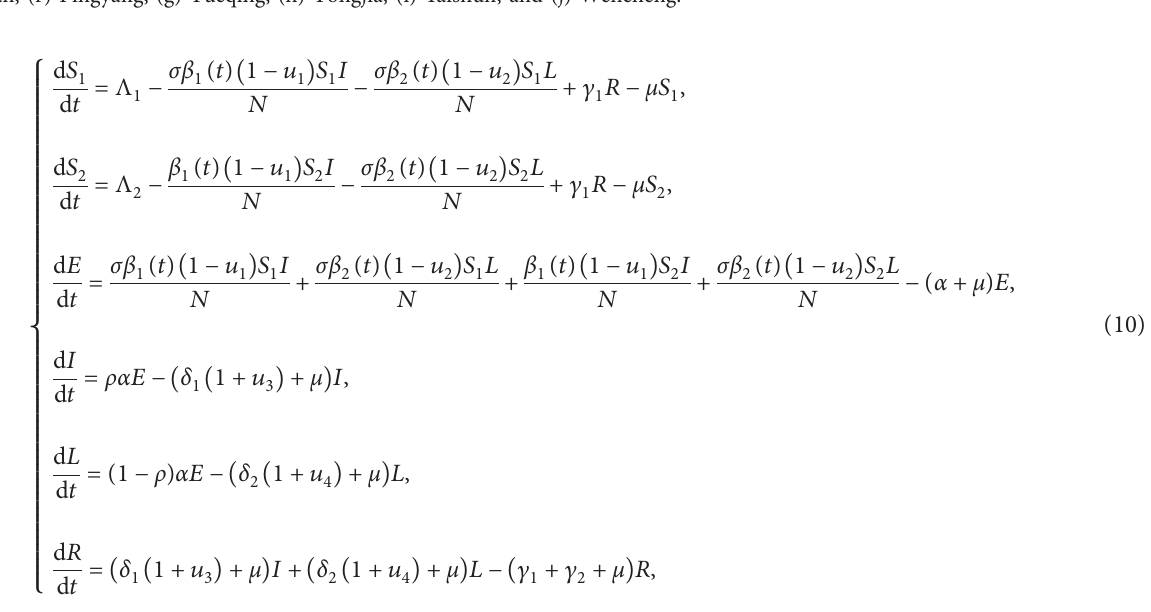
Figure 4: The reported data vs. the numerical solution of the HFMD model (1) in (a) Lucheng, (b) Ouhai, (c) Longwan, (d) Rui’an, (e) Cangnan, (f) Pingyang, (g) Yueqing, (h) Yongjia, (i) Taishun, and (j)